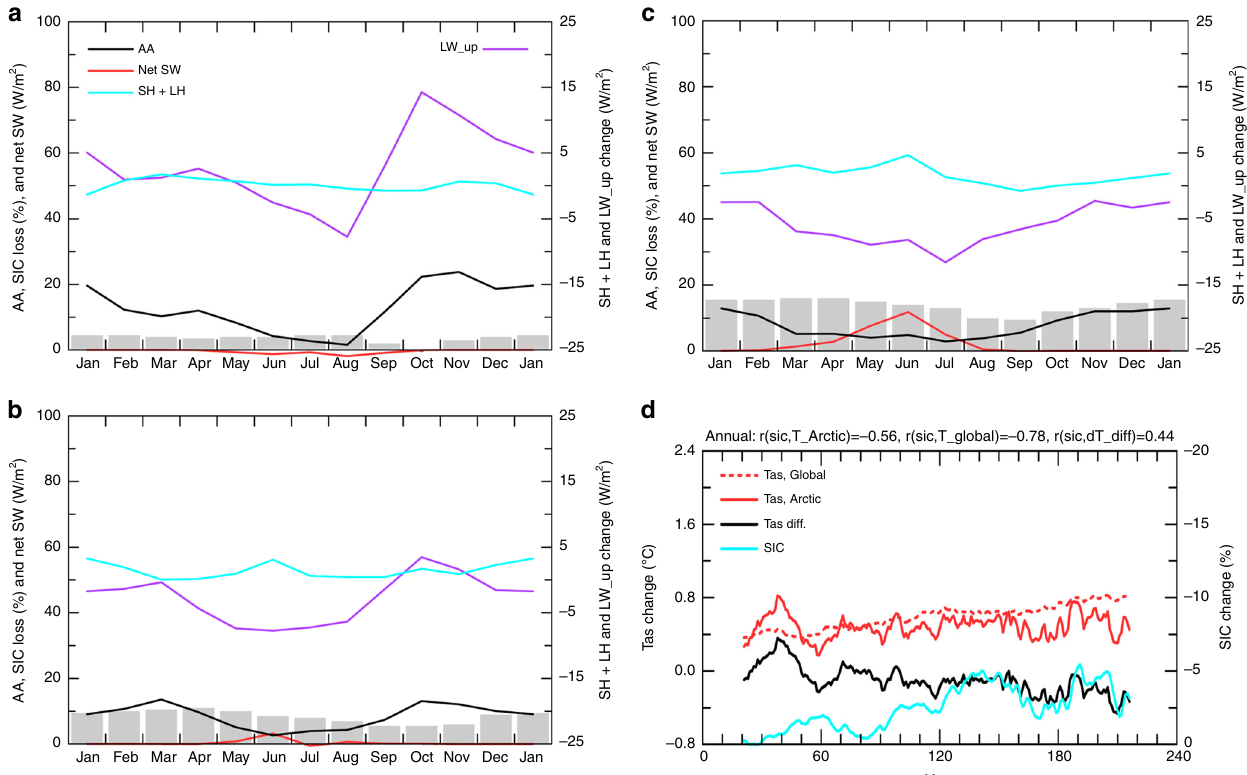
Fig. 8 Centennial changes as a function of month from CESM1 special simulation with fi xed sea-ice cover. Same as Fig. 7 except for the 1%-per-year CO 2 run with fi xed sea-ice in calculating the ice – atmosphere and ice – ocean fl uxes (FixedIce run). Note the upward longwave radiation change (LW_up) is plotted on the right y-axis in a – c here. d Time-dependent warming and sea-ice loss from CESM1 simulation with fi xed sea-ice cover. Same as Fig. 3d except for the CESM1 FixedIce (http://cmip-pcmdi.llnl.gov/cmip5/index.html). Only nine of the models had simulations extended to 2300 under the extended RCP8.5 scenario 39 . These are bcc-csm1-1, CCSM4, CNRM-CM5, CSIRO-Mk3-6-0, GISS-E2-H, GISS-E2-R, HadGEM2-ES, IPSL-CM5A-LR, and MPI-ESM-LR. The surface warming pattern